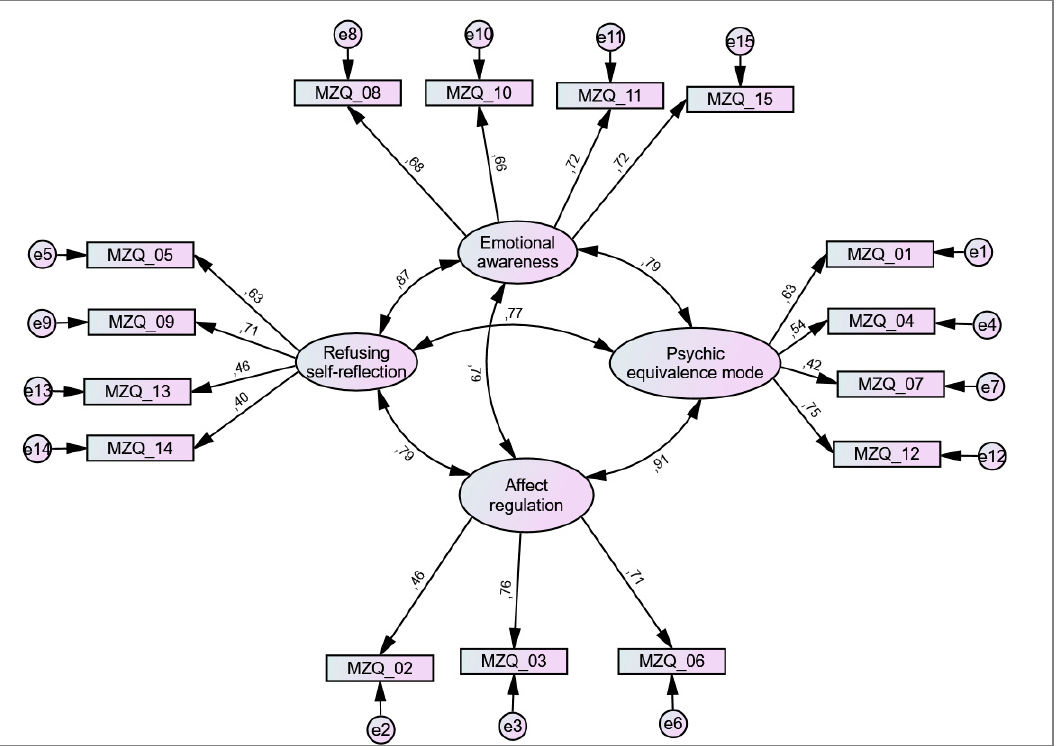
Figure 1. Previously proposed 4-factor solution for the Mentalization Questionnaire (MZQ). Large circles represent proposed factors, rectangles represent items (with corresponding item number), and small circles represent error terms (e). Numbers next to arrows in the model represent standardized estimates.